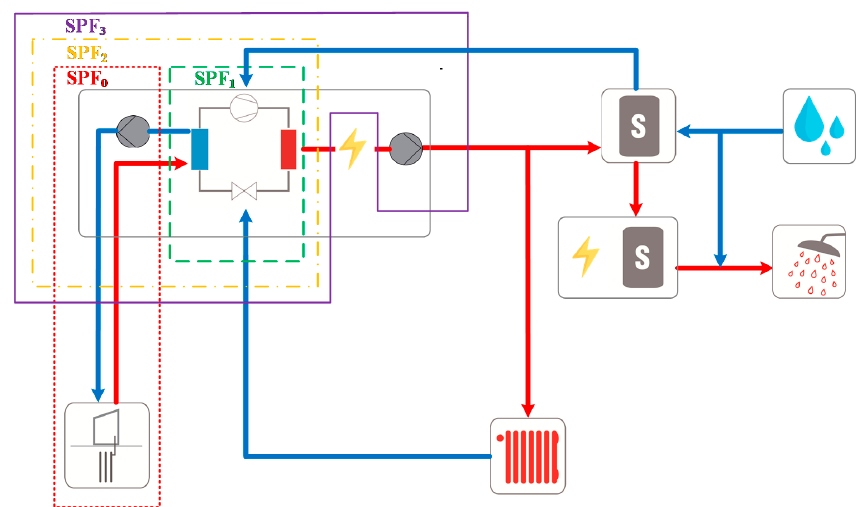
Figure 6. Annex 52 boundary levels 0, 1, 2, and 3 applied to the clubhouse GSHP system. Pictograms in drawing used with permission from TU Braunschweig IGS.